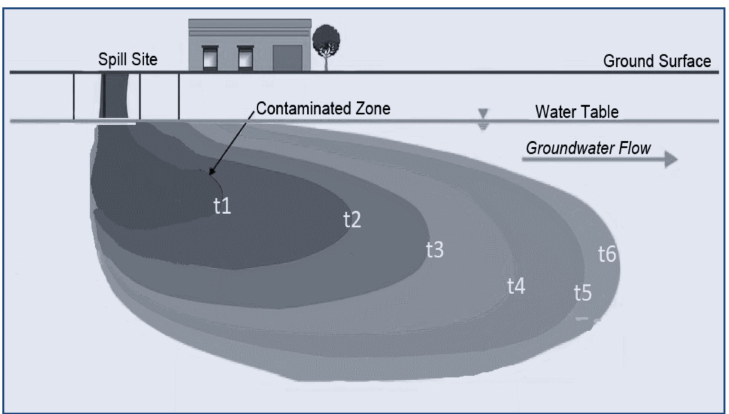
Figure 1. Contaminants concentration development in groundwater (“t1, t2–t6” are time